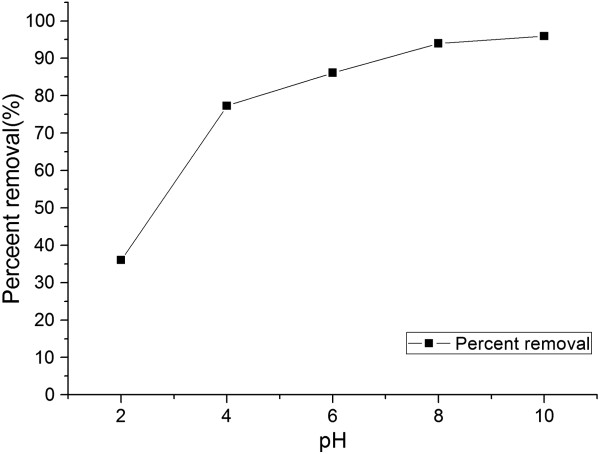
Effect of solution pH on the biosorption of MG.